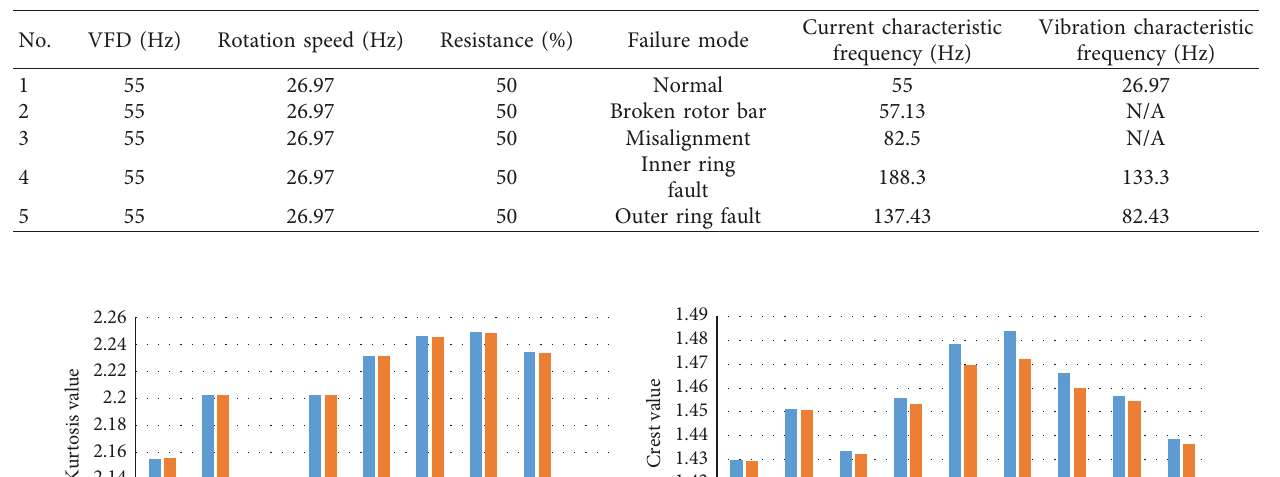
Table 2: Parameters of the experiment.